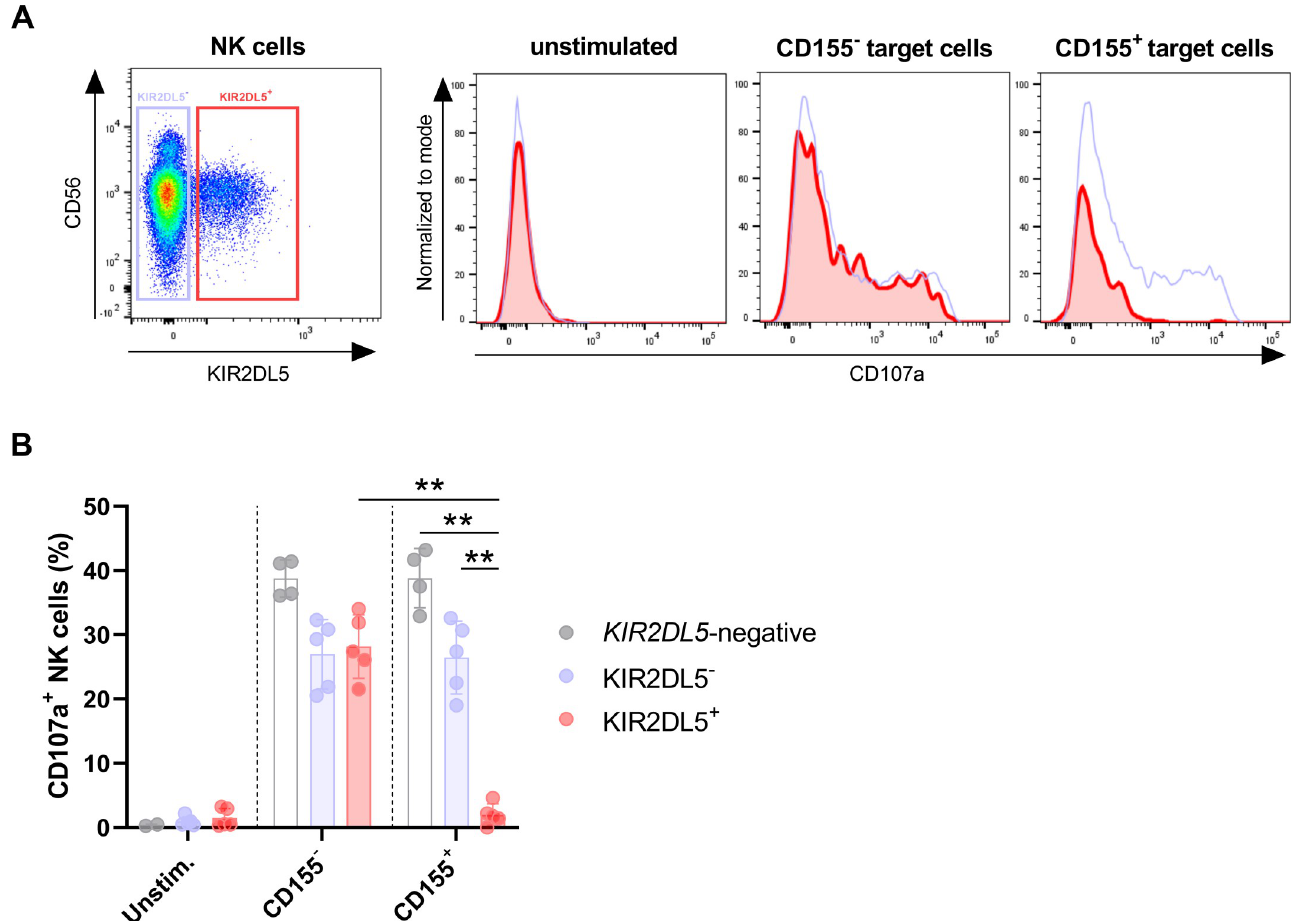
Fig 3. Primary human KIR2DL5 + NK cells are inhibited by CD155-expressing target cells. (A) Degranulation of KIR2DL5 + (red) and KIR2DL5 - (blue) NK cells was defined as percentage of CD107a + NK cells after co-incubation with CD155 - 721.221 target cells, CD155 + 721.221 target cells or left unstimulated. Plots show one representative experiment out of five independent experiments. (B) Percentage of CD107a-positive NK cells after co-incubation with target cells is shown as indicated before. Bars indicate mean values with standard deviations of KIR2DL5 + donors ( n = 5 from 5 donors) and KIR2DL5 -negative donors ( n = 4 from 2 donors). Mann-Whitney test was used to calculate statistical significance of differences in CD107a levels (KIR2DL5 - versus KIR2DL5 + NK cells p = 0.008; KIR2DL5 -negative versus KIR2DL5 + NK cells p = 0.016; KIR2DL5 + NK cells co-cultured with CD155 + or CD155 - target cells p = 0.008).